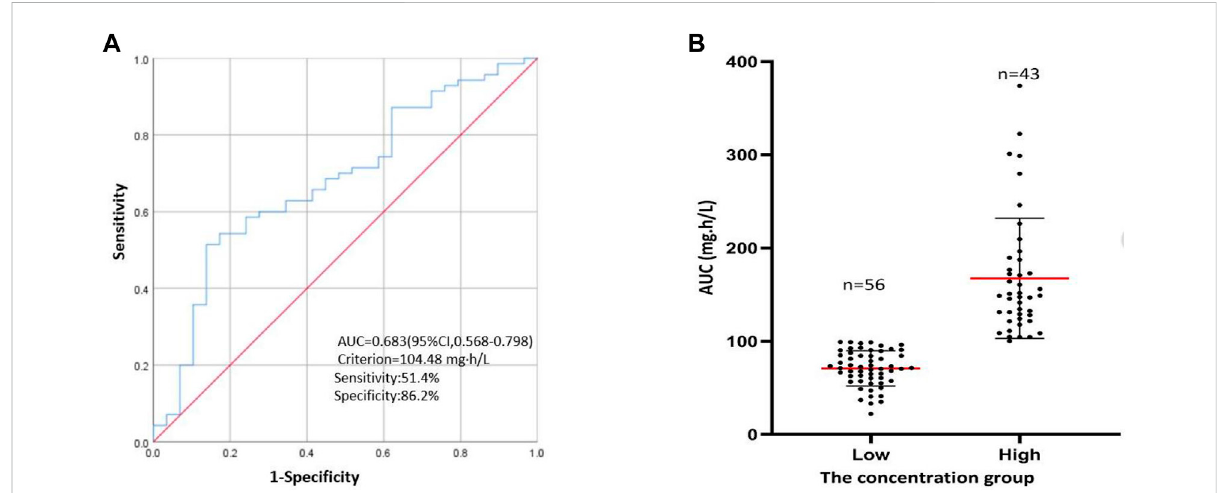
The concentration group. (A) ROC curve for values of pirfenidone plasma concentration to predict the progression in IPF patients. (B) The distributionfor thetwo different concentrations, thehorizontal redlines represent themeanvalueandthelower and upperblack linesrepresent the S = D value,